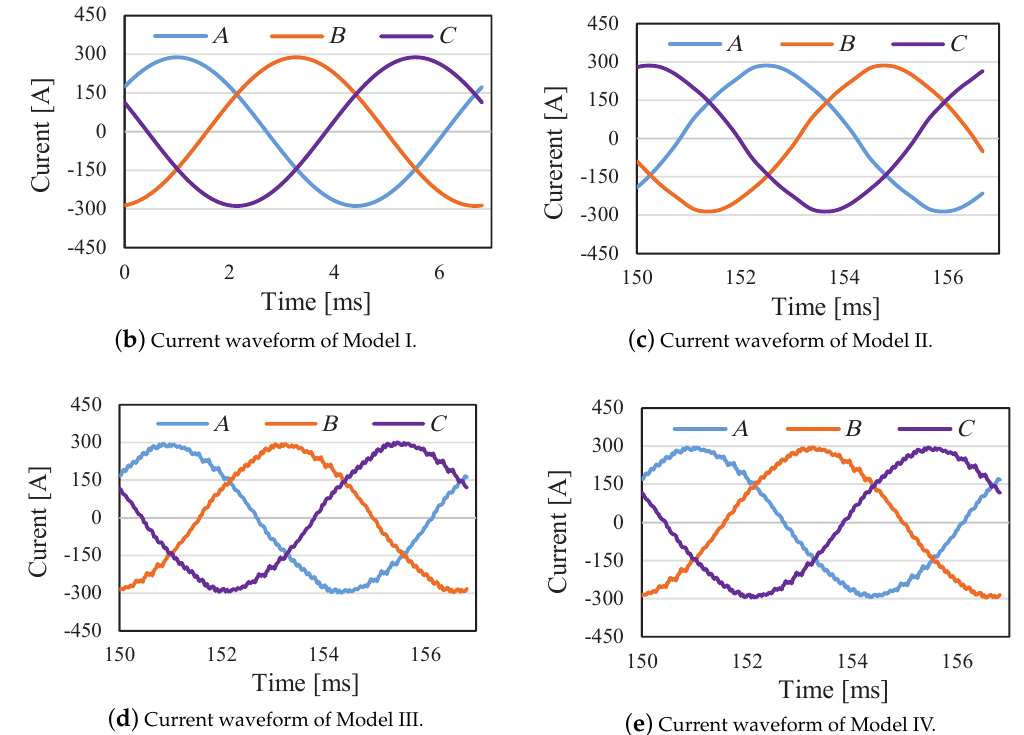
Figure 9. Comparison of current waveforms in different models. ( a ) Experimental current waveform. ( b ) Current waveform of Model I. ( c ) Current waveform of Model II. ( d ) Current waveform of